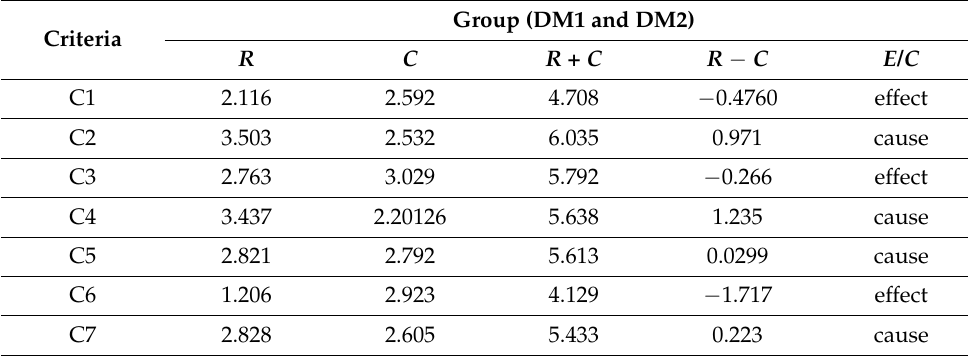
Table 6. DEMATEL total relation matrix—group context.